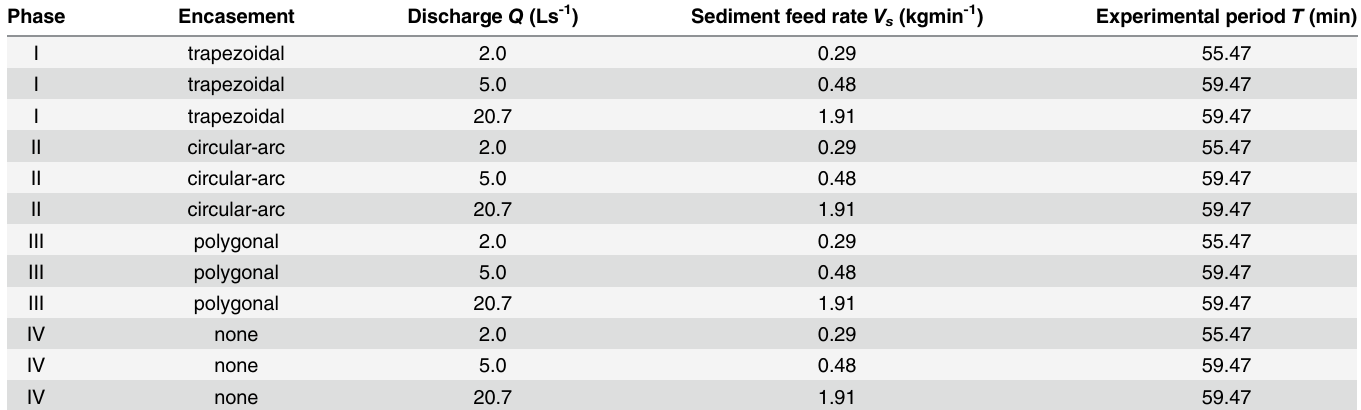
Table 1. Experimental conditions for Phases I-III (with encasements) and IV (without encasements).